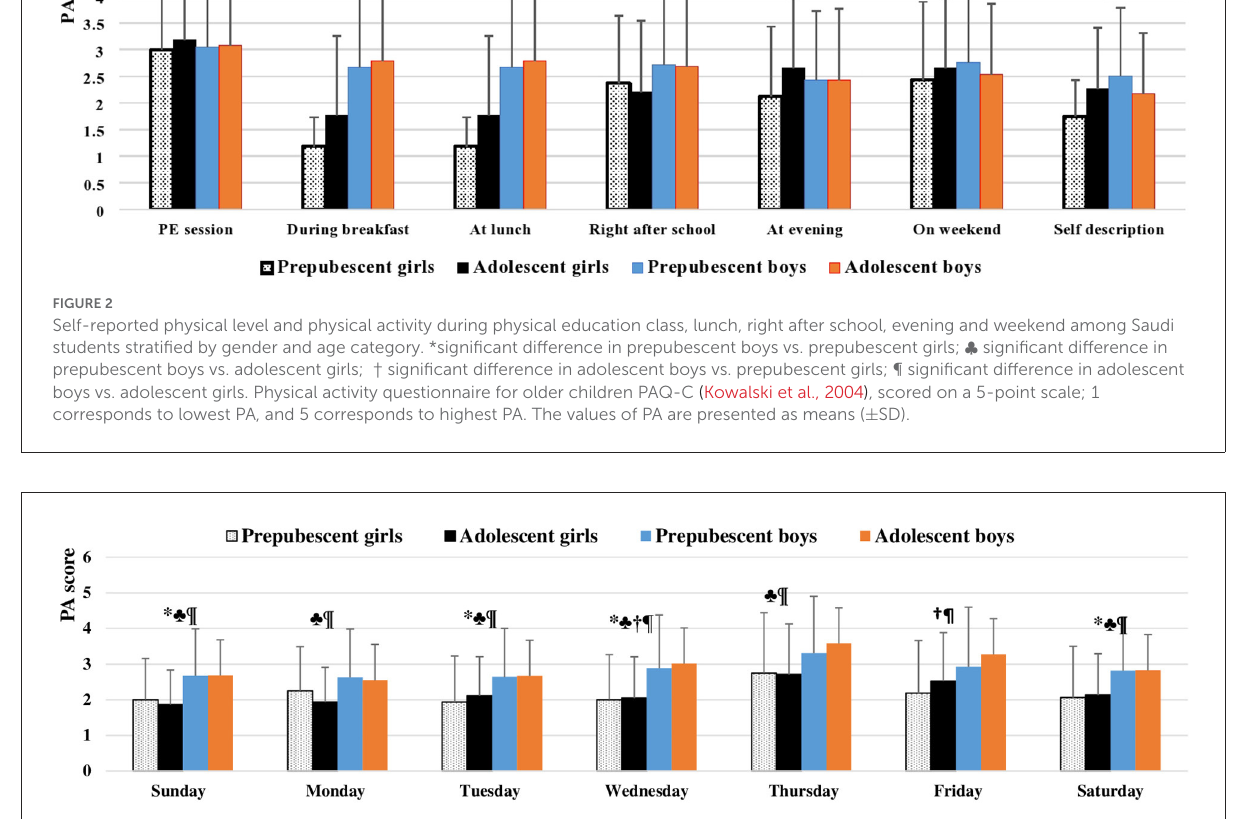
FIGURE3 Mean value of physical activity self-report for each day during previous week in Saudi students stratified by sex and age category. * significant difference in prepubescent boys vs. prepubescent girls; ♣ significant difference in prepubescent boys vs. adolescent girls; † significant difference in adolescent boys vs. prepubescent girls; ¶ significant difference in adolescent boys vs. adolescent girls. Physical activity questionnaire for older children PAQ-C (Kowalski et al., 2004), scored on a 5-point scale; 1 corresponds to lowest PA, and 5 corresponds to highest PA. The values of PA are presented as means ( ±